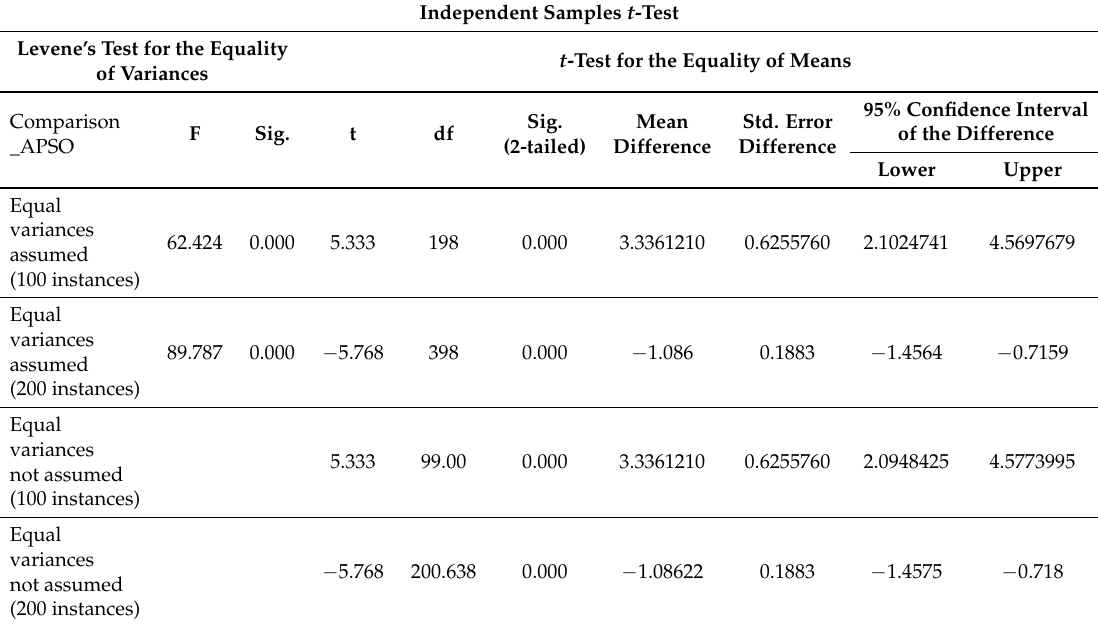
Table 3. SPSS results of independent sample t -test showing the comparison between simple APSO and improved APSO on the pumped storage non-cascaded STHTS